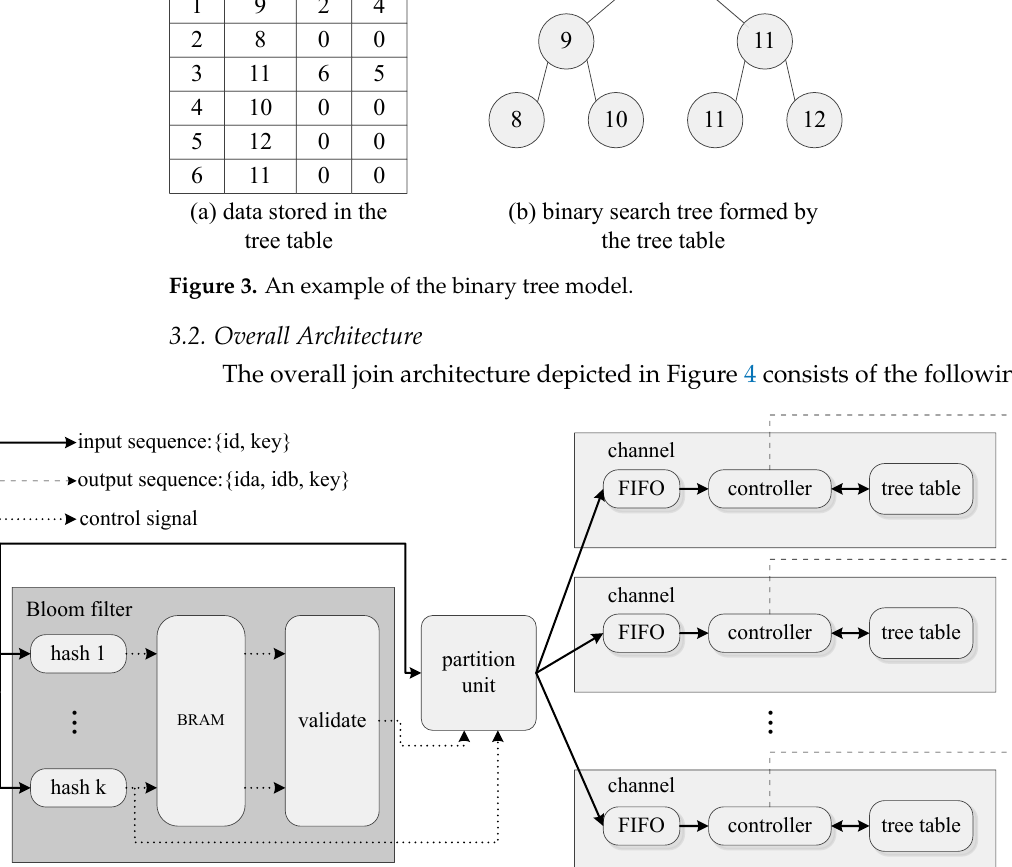
Figure 4. The proposed overall architecture. The tuples of the input sequence are in the {id, key} format in both the build and probe phase. The tuples of the output sequence are in the {ida, idb, key}